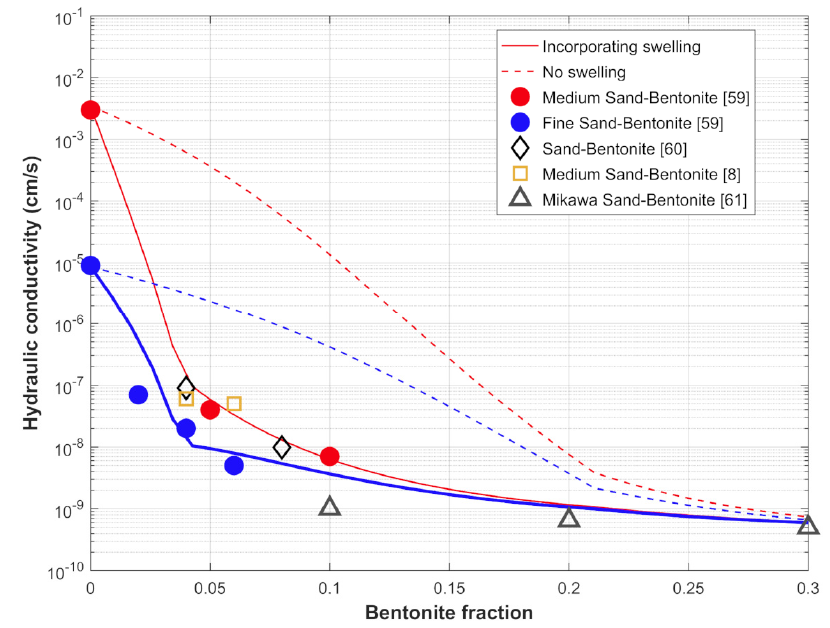
Figure 9. Hydraulic conductivity as function of bentonite fraction for various sand–bentonite mixtures. The figure shows bentonite fraction up to only 0.3 to highlight the impact of ignoring swelling which is most significant at low bentonite fraction. The prediction of the current model (Equations (13)–(18) and (19)–(21), S = 10)is shown in bold solid curves while the prediction using the approach presented by Zhang et al. [25] (Equations (1)–(3) and (19)–(21)) is shown in dashed curves. The mean absolute error in predicting K using the presented modified model is 0.032 cm/s while it is 0.064 cm/s when following the original model developed by Zhang et al. [25]. That is, the use of the current modified model reduces the mean absolute error in predicting K of binary mixed soils by 50%. Moreover, an important advantage of the current model is that it is applicable for wide range of binary mixed soils covering different particle sizes and fines types. It is a “unified” model that takes into account variable factors